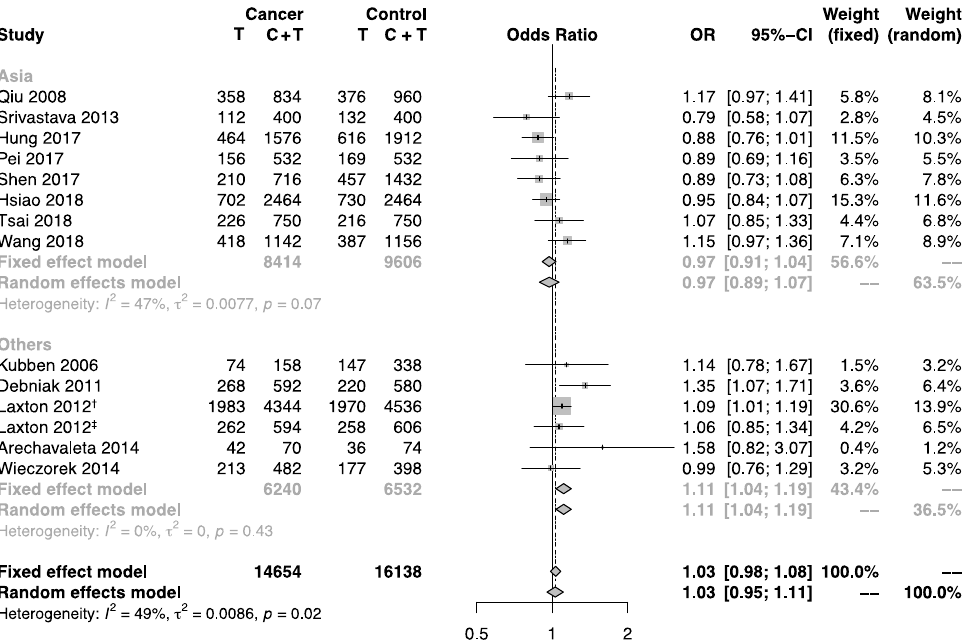
Figure 3. Forest plot showing the association between the MMP-8 rs11225395 polymorphism and cancer risk in subgroup analysis by region. The pooled estimates were calculated under the allele model. The size of each gray square is proportional to the weight calculated under the fixed effect model, a black dot in a box indicates the odds ratio (OR), and black lines on either end mark the corresponding 95% confidence interval (CI). The gray diamonds represent the overall summary estimate, with 95% CI represented by their widths. The dotted vertical line and the dashed one indicate the pooled ORs calculated by the random effects model and fixed effect model, respectively. The black unbroken vertical line marks the null hypothesis (OR = 1). † marks the population of the United Kingdom in Laxton’s study (2012), and ‡ marks the population of Poland in Laxton’s study (2012).